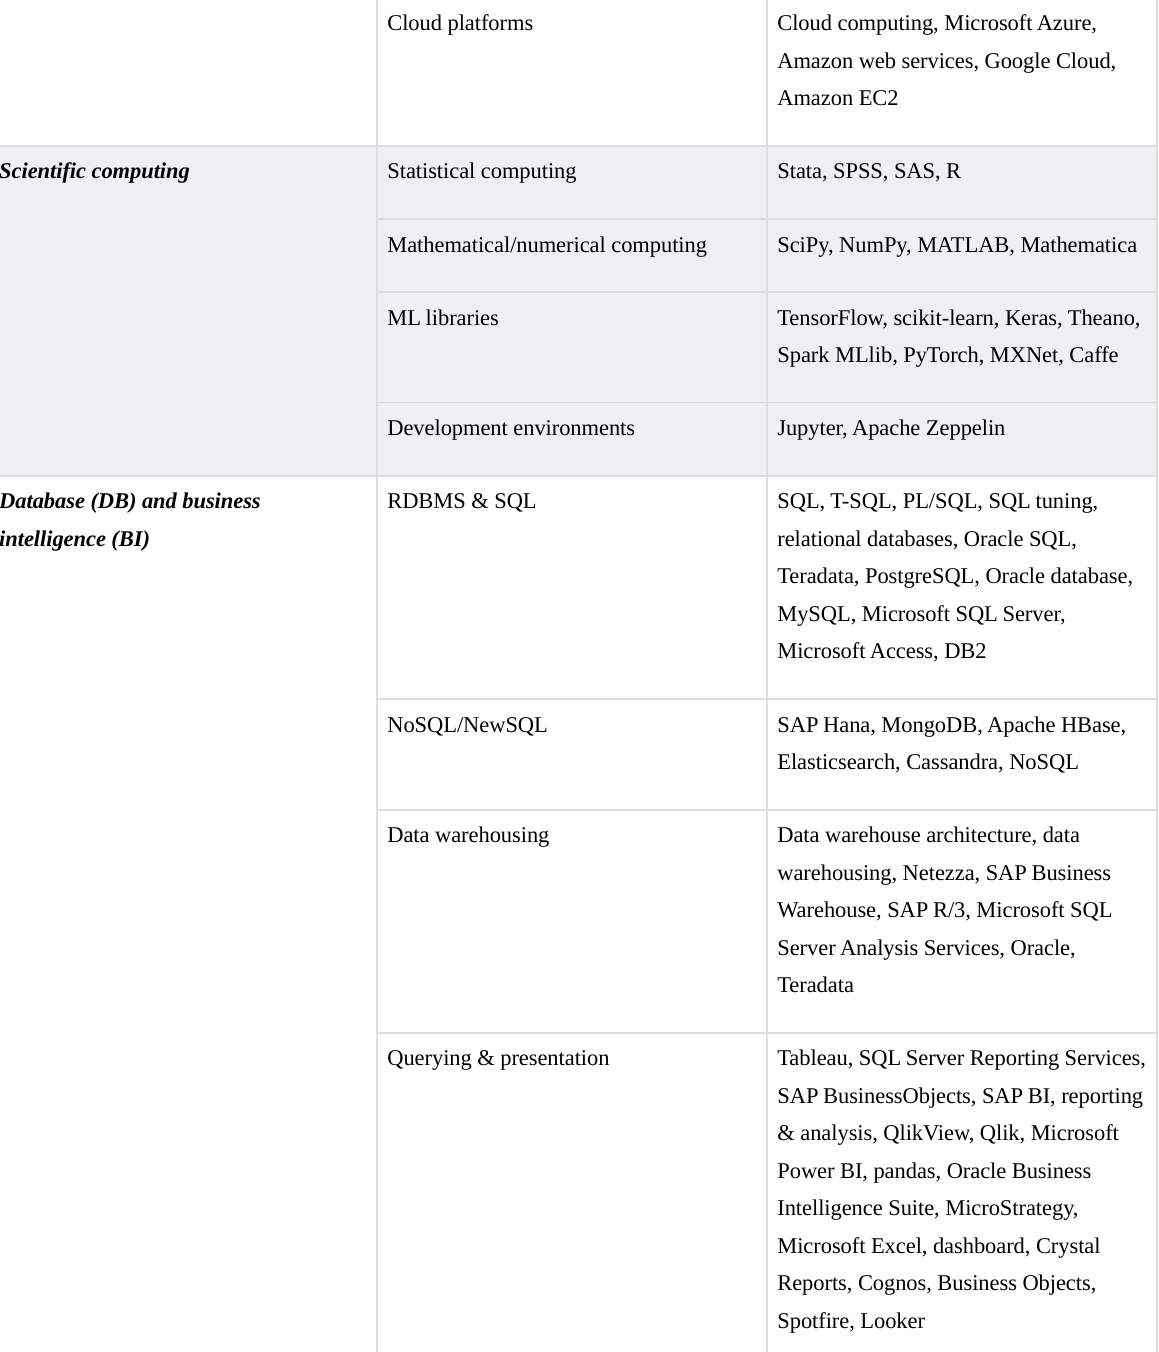
Tableau, SQL Server Reporting